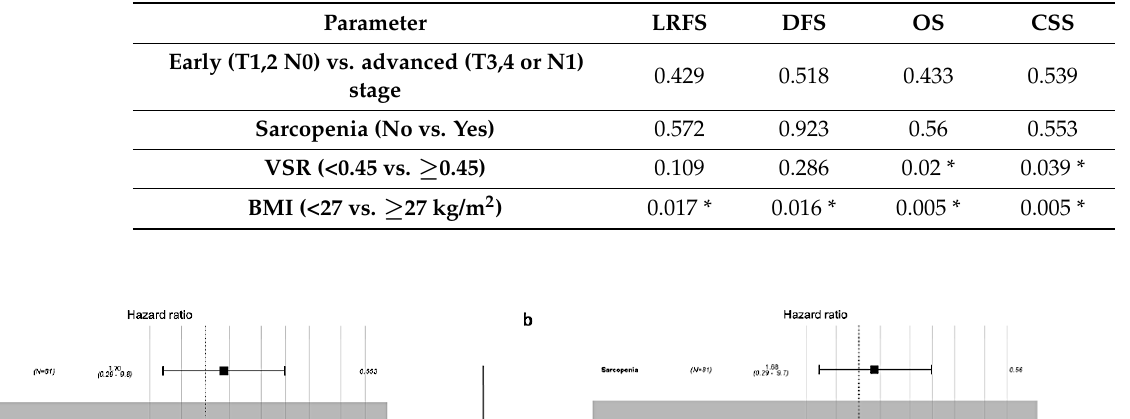
Table 4. BMI: body mass index; VSR: visceral-to-subcutaneous fat ratio, Cox regression analysis, * p -value < 0.05: significant.